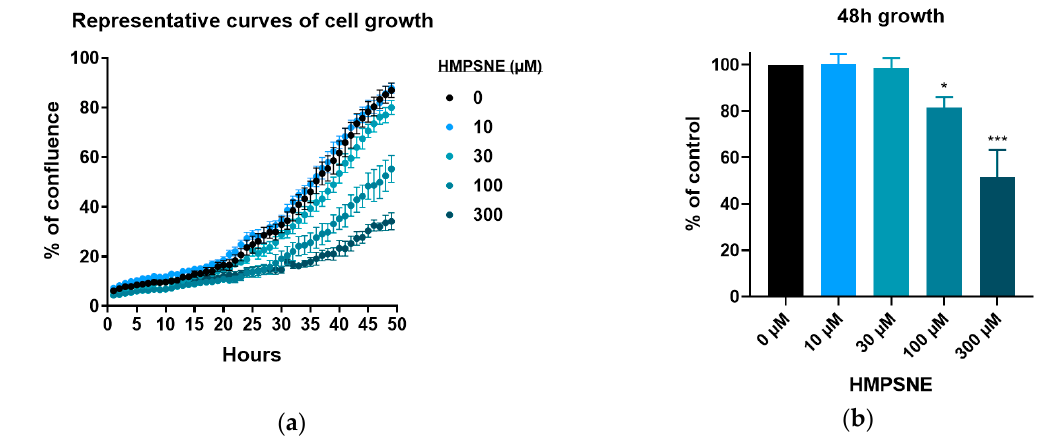
Figure 5. 3-MST inhibition slows down proliferation of CT26: ( a ) Confluence of cells untreated or treated with HMPSNE at very low density was recorded each hour for 48 h. Data are presented as mean ± SEM of three replicates; ( b ) Cell confluence after 48 h growth shown as percentage of untreated cells. Data are presented as mean ± SEM of minimum three independent experiments and Dunnett’s multiple comparisons tests are shown vs. 0 µ M (* p < 0.05, ** p < 0.01, *** p < 0.001).